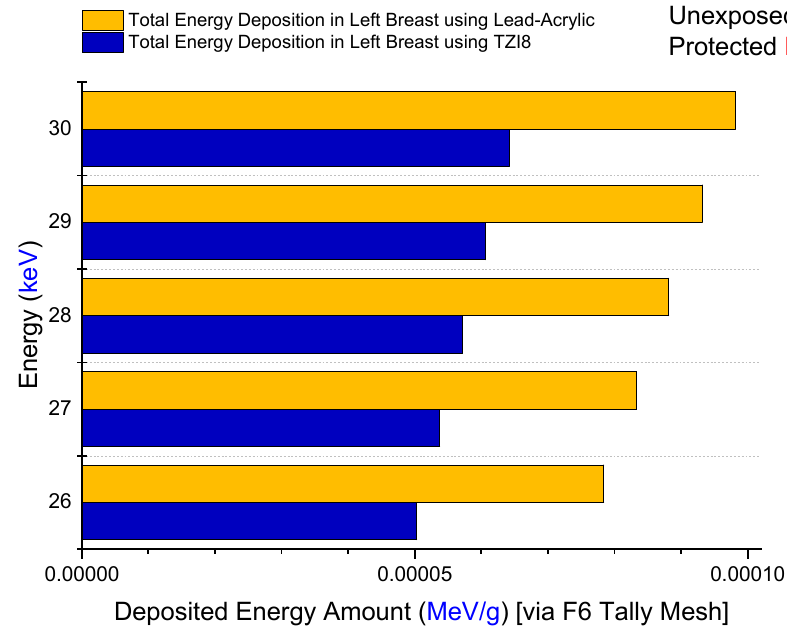
Figure 9. Variation in deposited-energy amount in unexposed and shielded left breast.